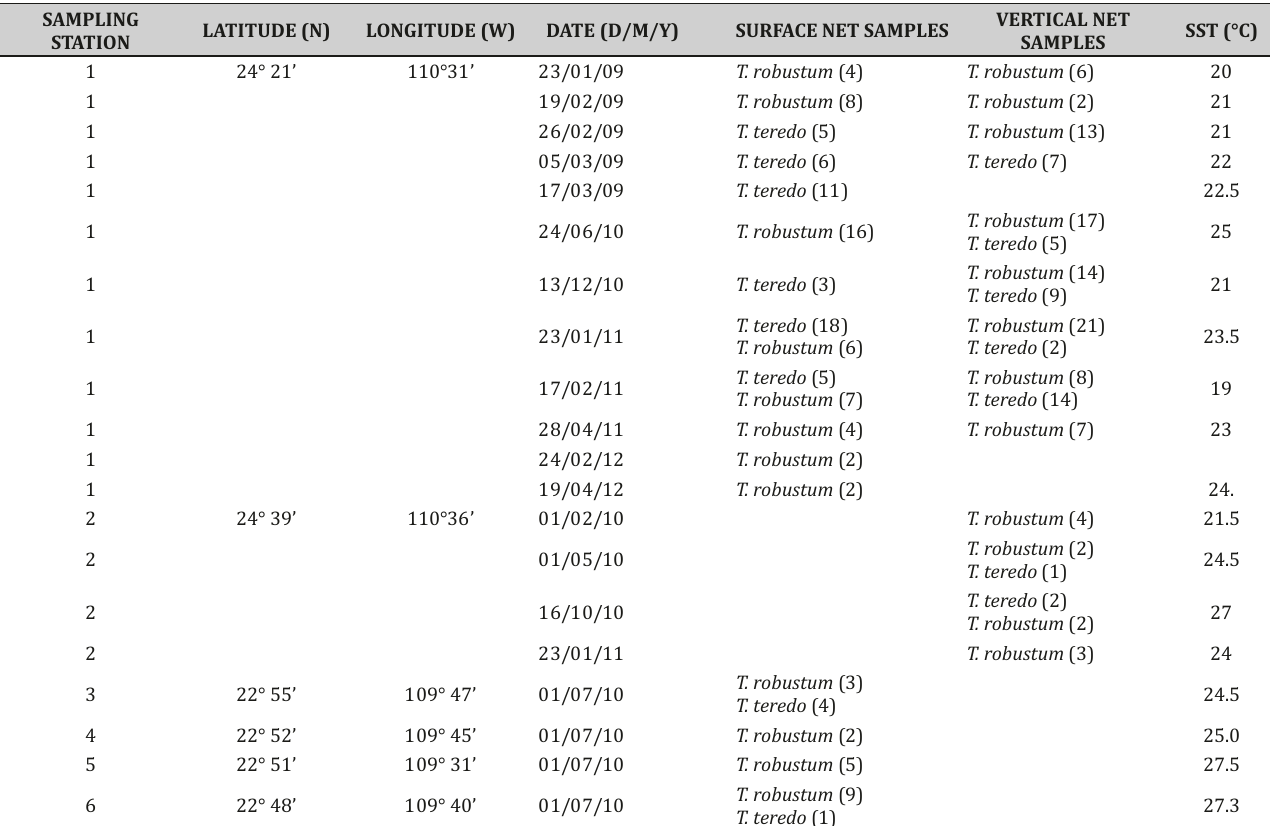
Torodinium robustum